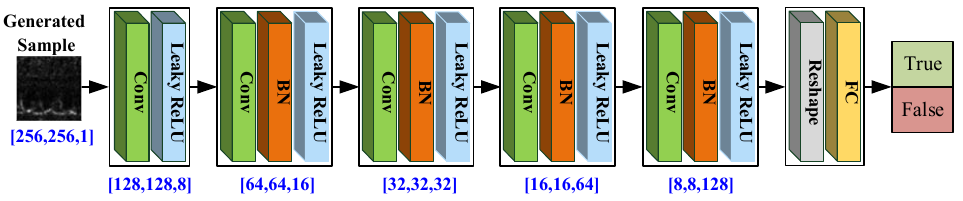
Figure 4. The WGAN discriminator architecture.